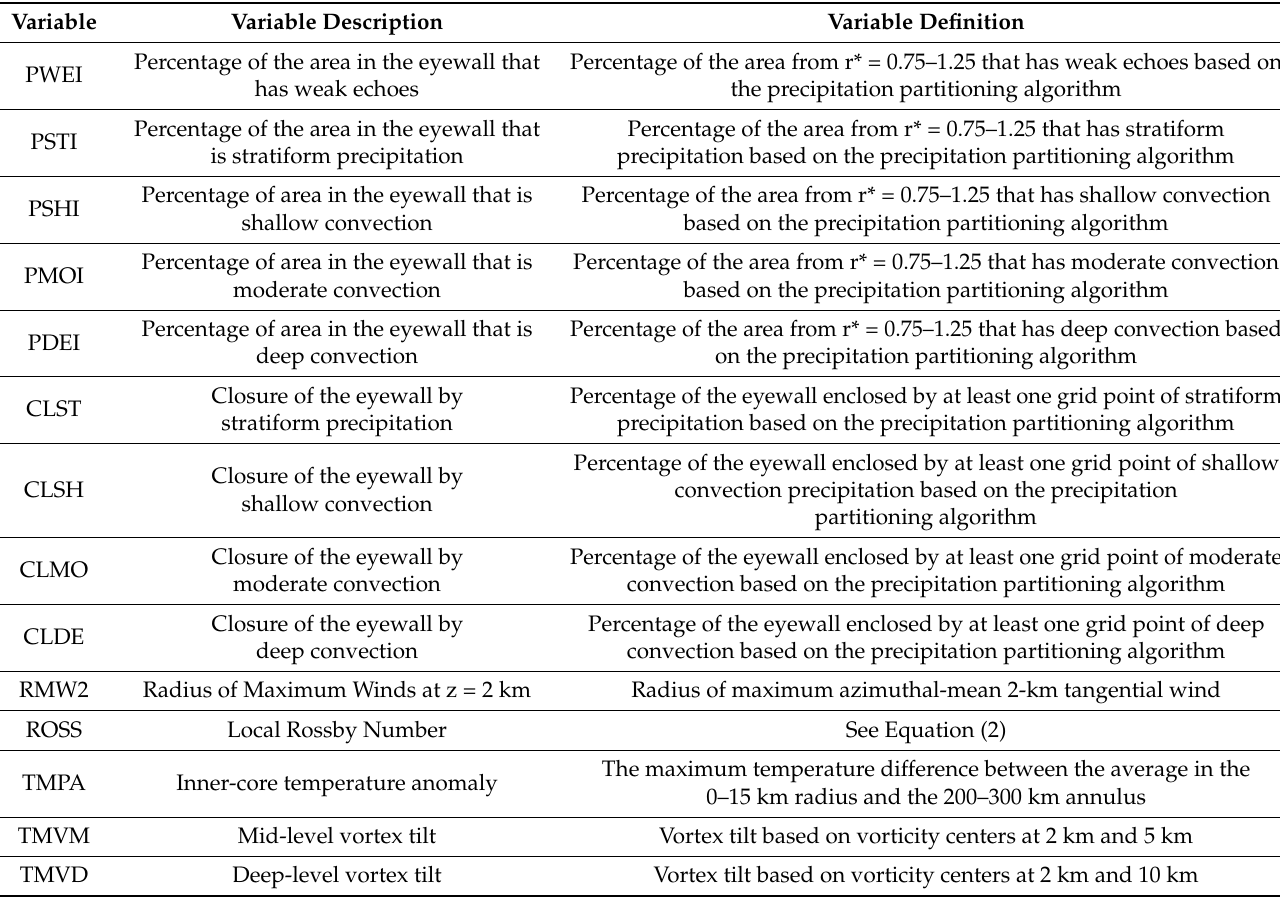
Table 3. Storm-scale structure variables calculated from the HAFS ensemble